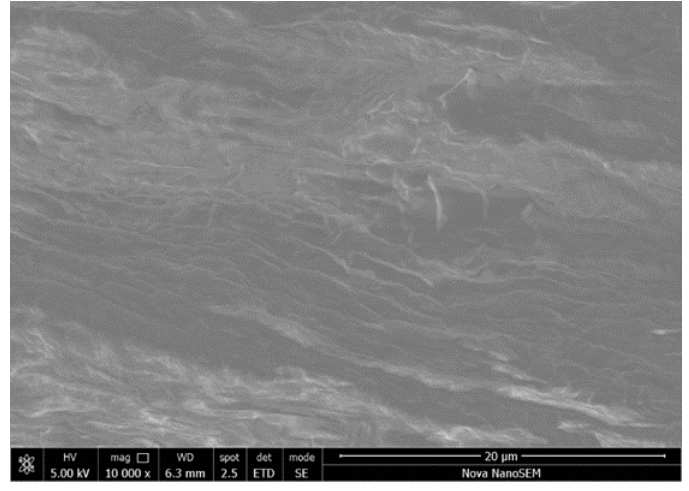
Figure 6. SEM image for BAM.